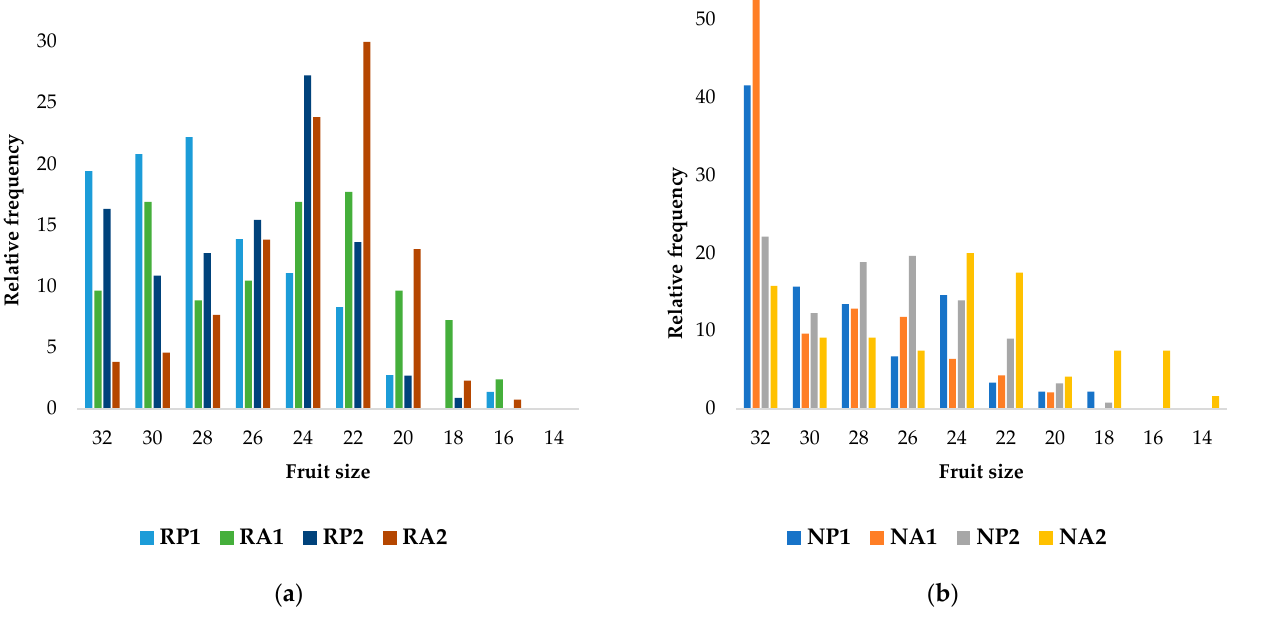
Figure 4. Fruit harvest size classification results according to the Codex Stand 197, 1995. ( a ) R orchard and ( b ) N orchard. P: Nutrient management of the farmer. A: Nutrient management program based on the BIK standards. 1. Harvest from the intermediate flowering period. 2. Harvest from the main flowering period.